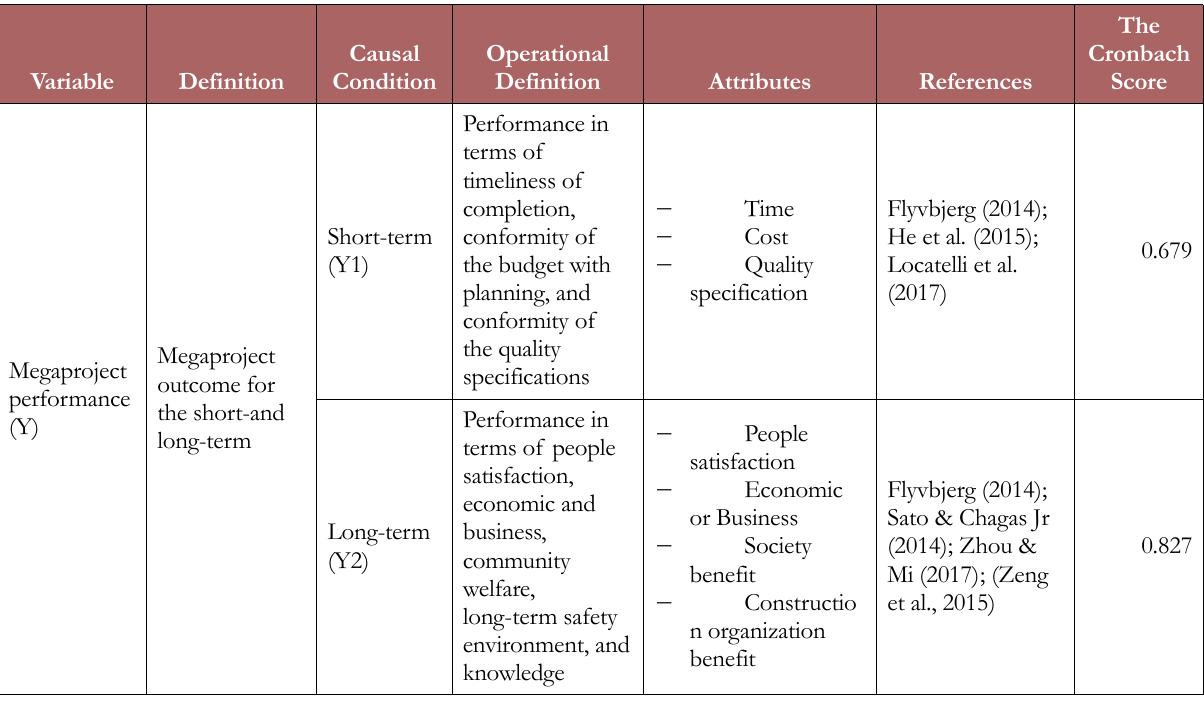
Table 1. The Variables and Attributes (Final